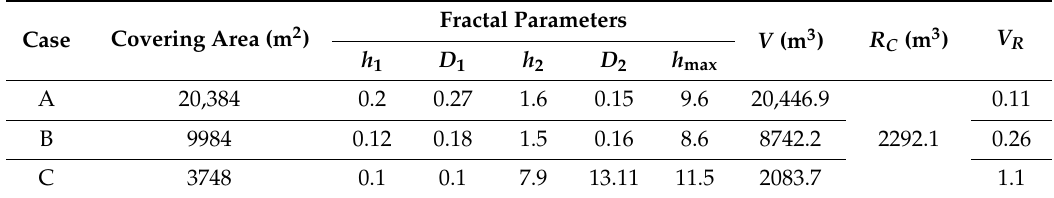
Table 1. Total volume estimates of the karst caverns and karst grouting coefficients for predicting the required volume of